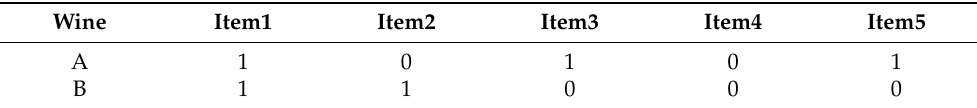
Table 1. Binary data example. For each label (A and B), the distance is calculated based on the comparison between the appearance of each item within that label. Jaccard distance is utilized for this type of data (binary).